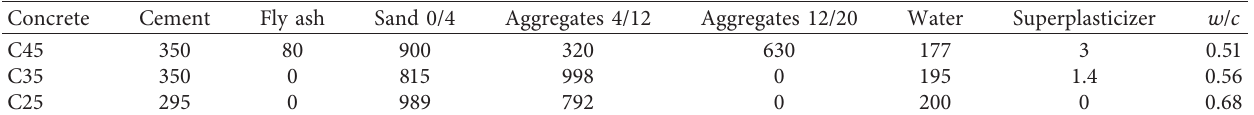
Table 6: Concrete mixes (kg/m 3 ).